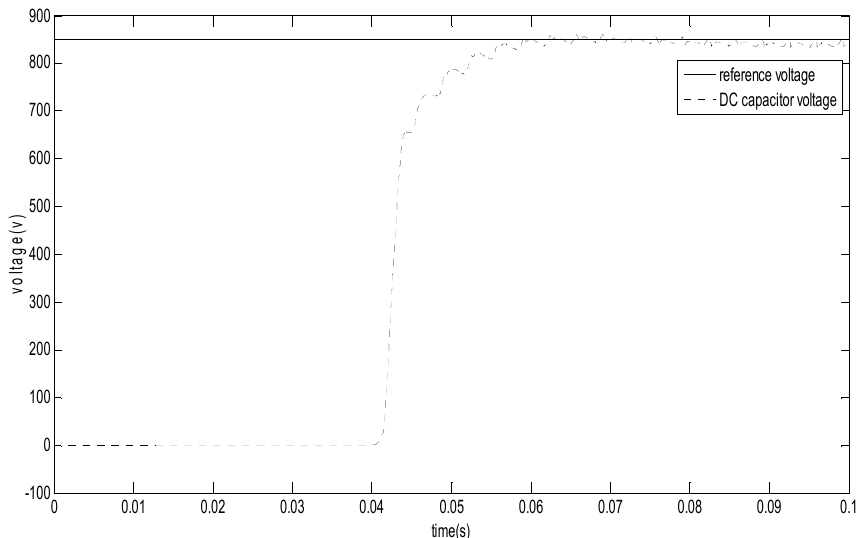
Figure 7. DC capacitor voltage without an increasing load.